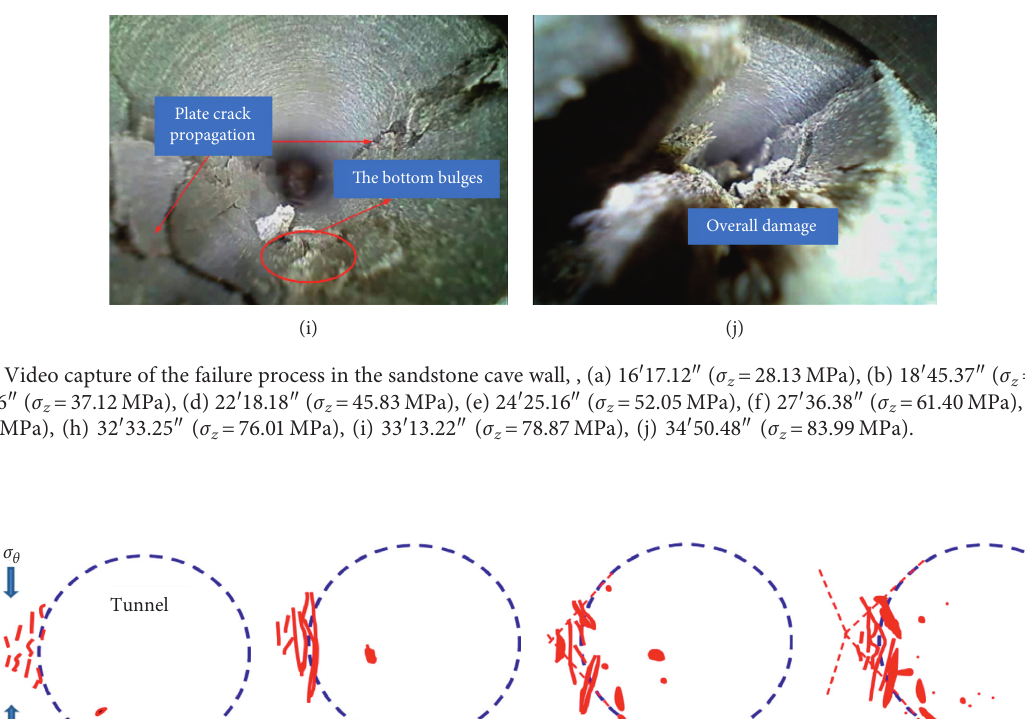
Figure 13: Failure diagram of roadway-surrounding